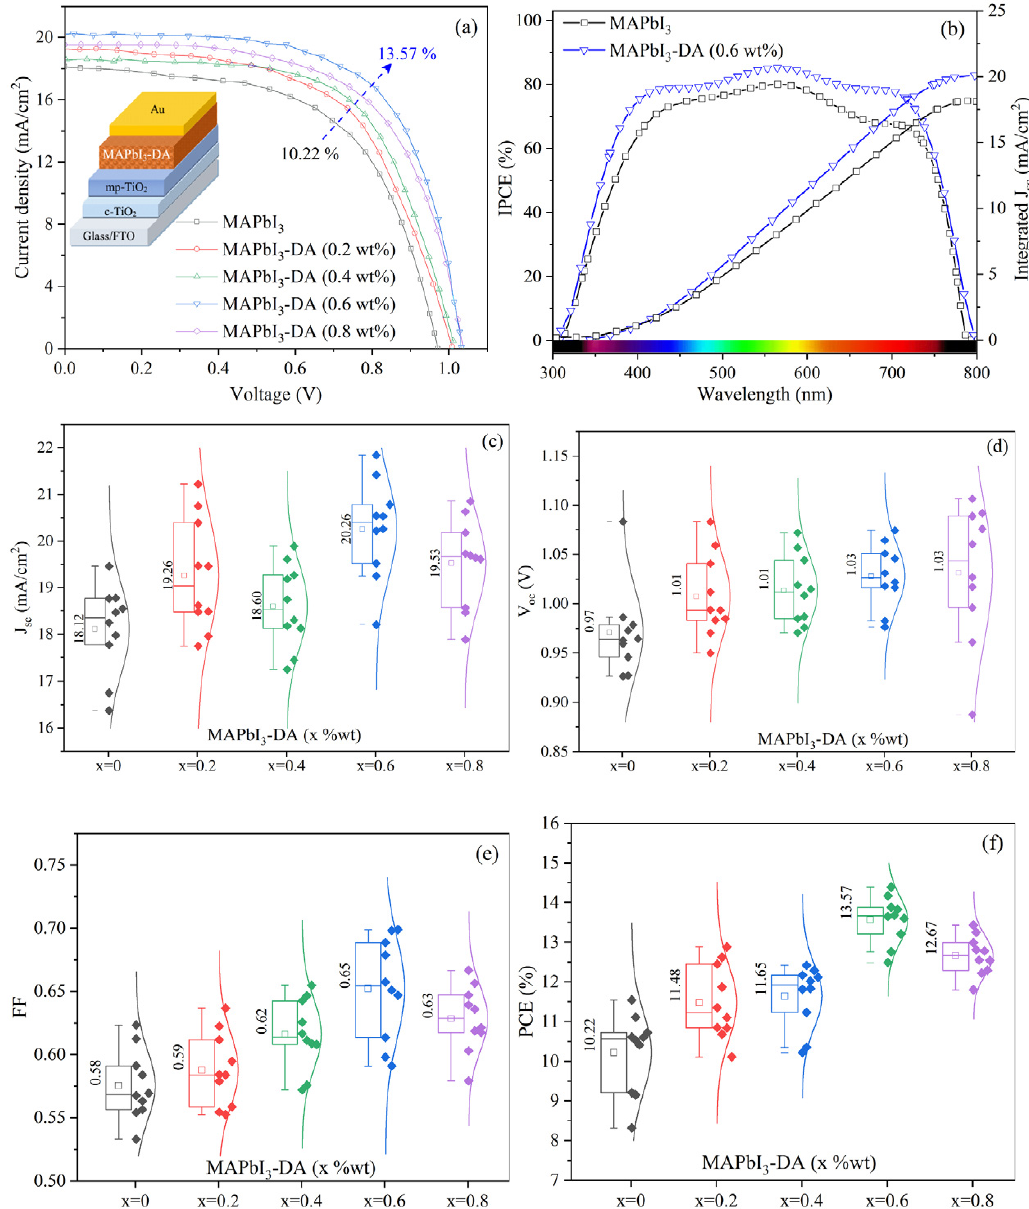
Fig. 5. (a) Averaged J- V curves of the PSCs with various concentrations of DA under illumination; (b) IPCE spectrum of the PSCs fabricated from precursor solution added with 0.4 wt% DA and the integration photocurrent curves of the PSCs; Statistical distribution and box-plots of photovoltaic parameters (c) J sc , (d) V oc , (e) FF, (f) PCE of a series of PSCs obtained from J–V curves under illumination.